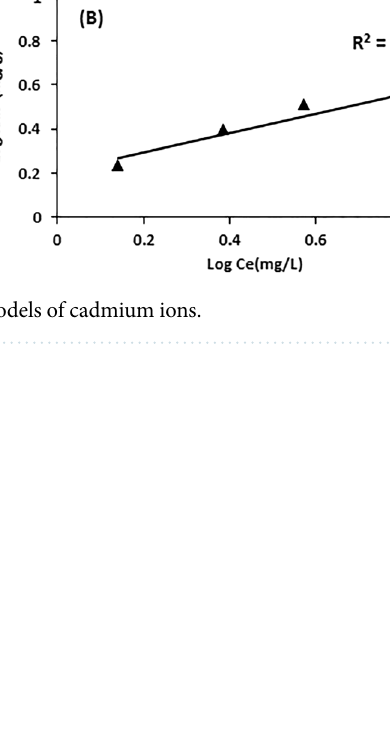
Table 2. Isotherm parameters for the sorption of cadmium ions on activated hydrochar.